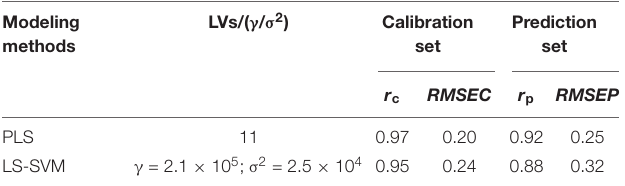
TABLE 3 | Prediction results of SSC by PLS and LS-SVM with full spectral data,